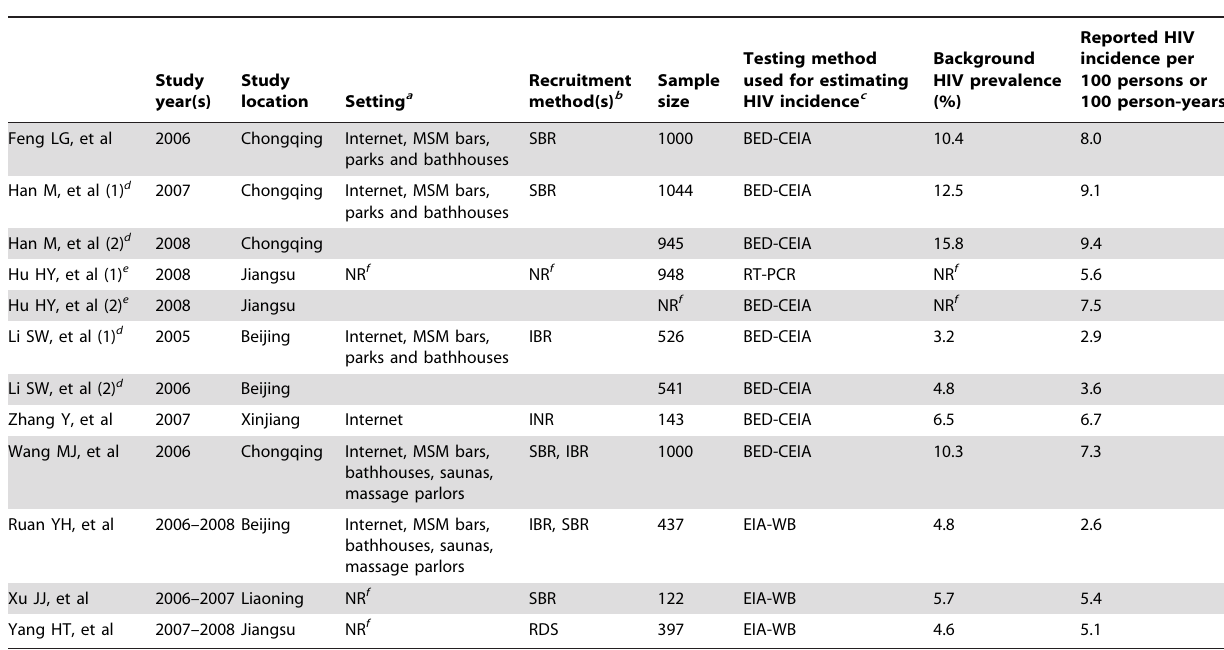
Table 1. Summarized information of the studies included in